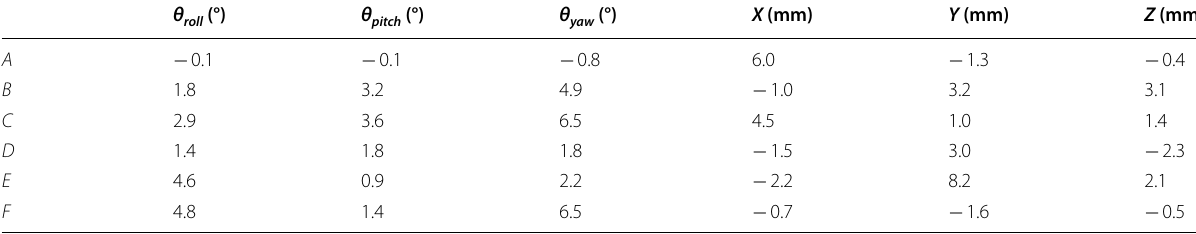
Table 4 The operation width difference between measuring and